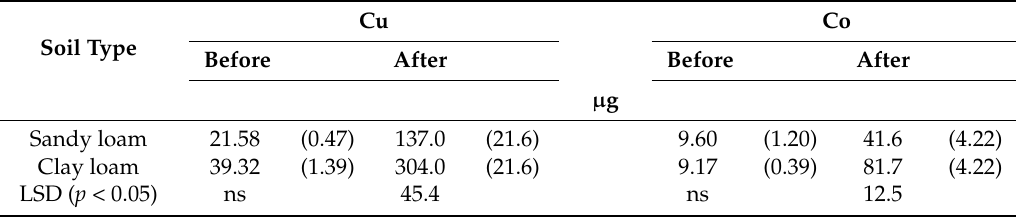
Table 5. Mean amounts of total Cu and Co extracted from sandy loam and clay loam soils before and after the soils were used in the greenhouse experiment. The numbers in parentheses are standard errors of means. Detection limits for Cu = 0.001 mg/L and Co = 0.006